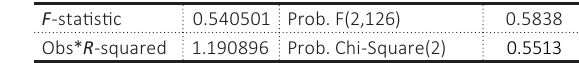
Table 6. Test for autocorrelation